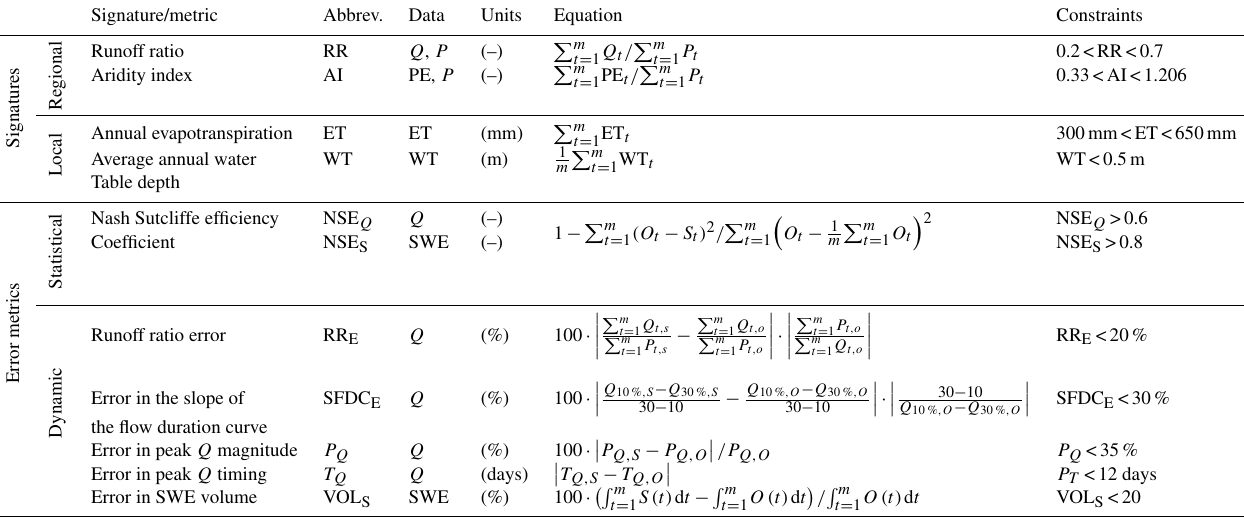
Table 2. Signatures and error metrics used in the analysis. The table contains abbreviations for each signature/error metric, units, the general equation used for calculation, and the constraints chosen to separate behavioral and non-behavioral runs. Abbreviations in equations refer to time step t , total number of time steps m , observed values O , and simulated value S